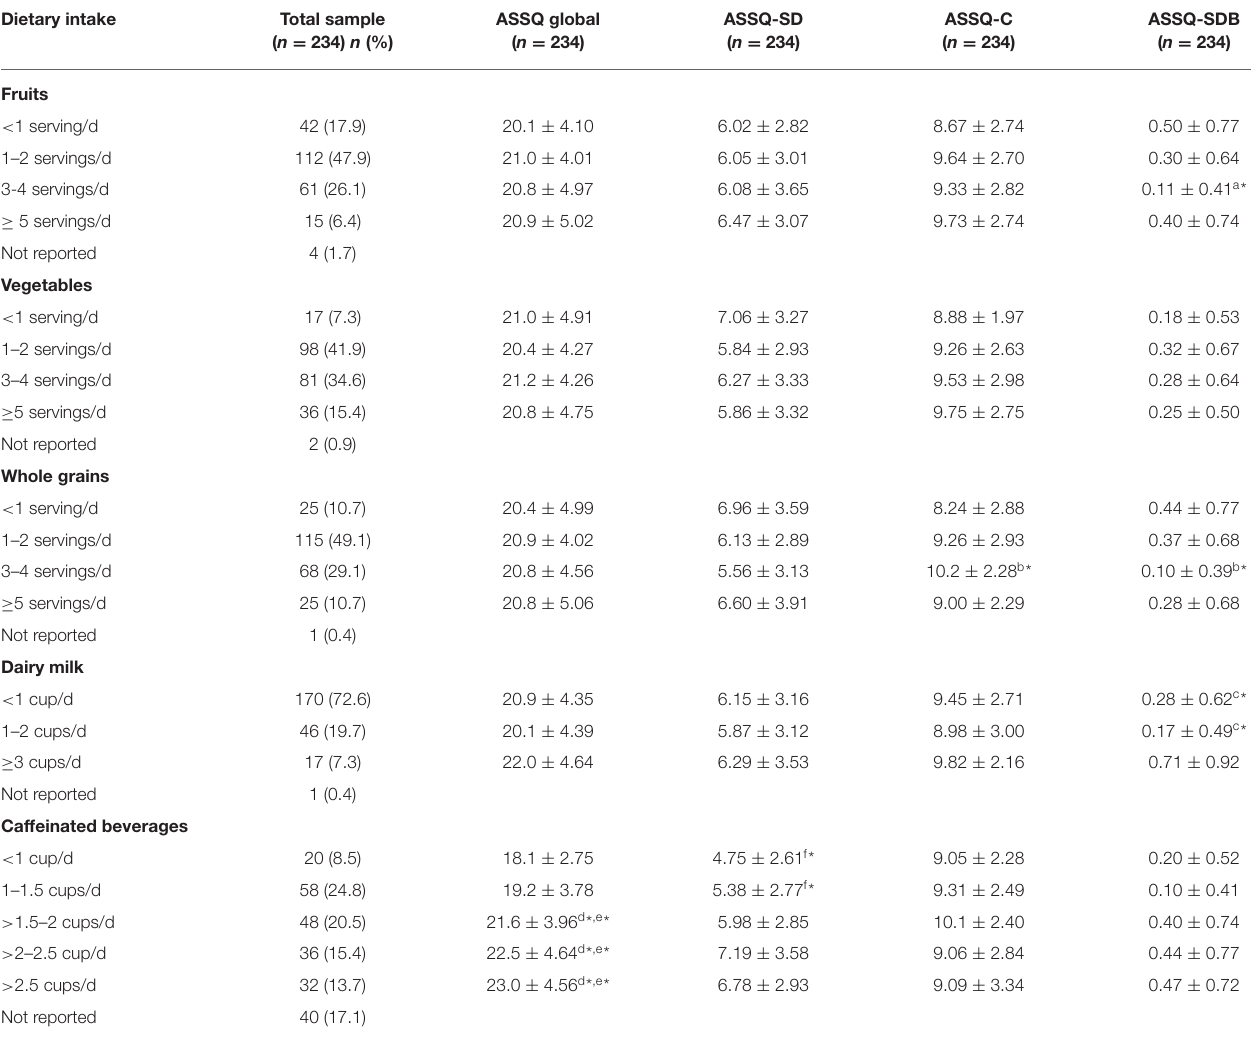
TABLE 2 | Sleep quality (ASSQ global) and subscale scores by dietary intake. Dietary intake Total sample